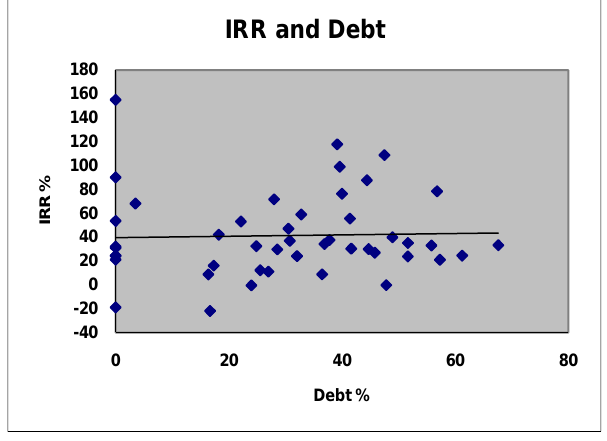
Figure 2: IRR and debt scatter plot Holding period